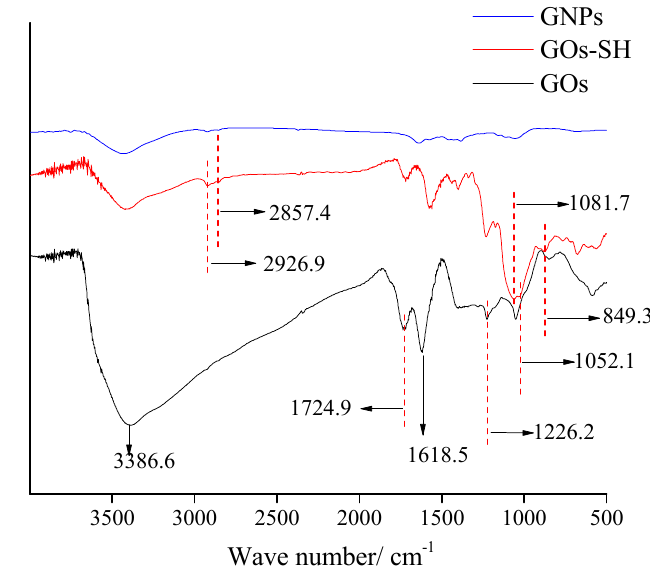
Figure 12. FT-IR spectra of GNPs, GOs-SH, and GOs.